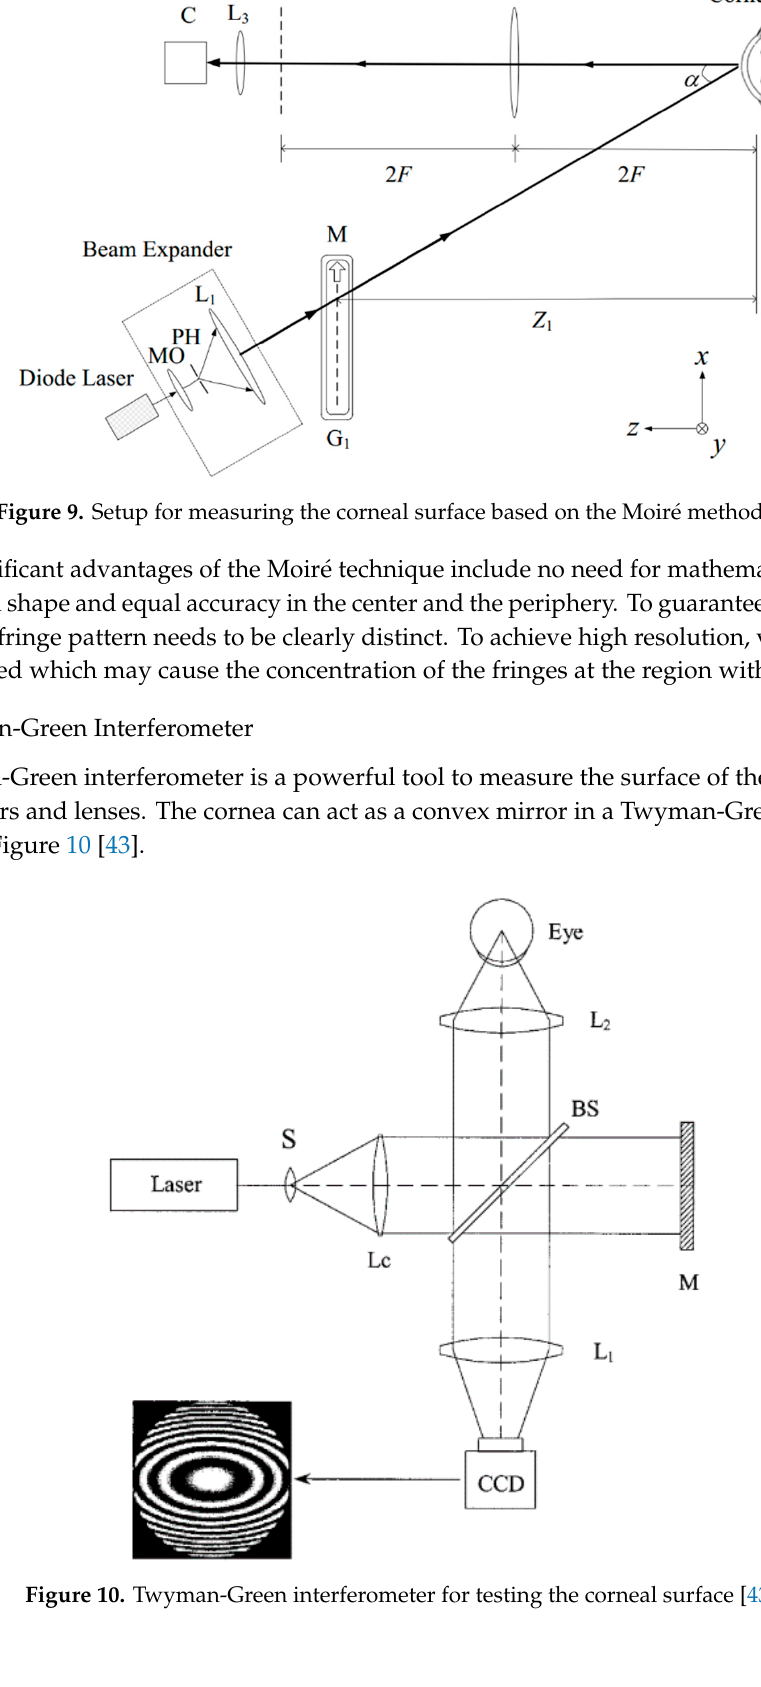
Figure 8. Optical schematic of the Maastricht Topographer [65].